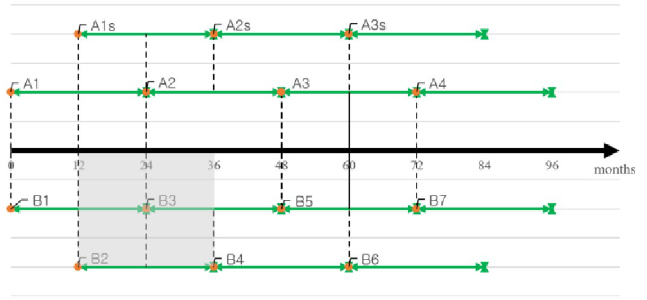
Fig 2. Life cycle of models for firms A and